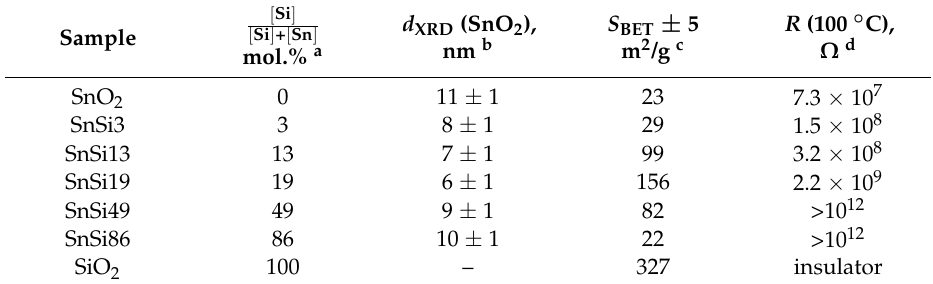
Composition, parameters of microstructure and electrophysical properties of the obtained samples.